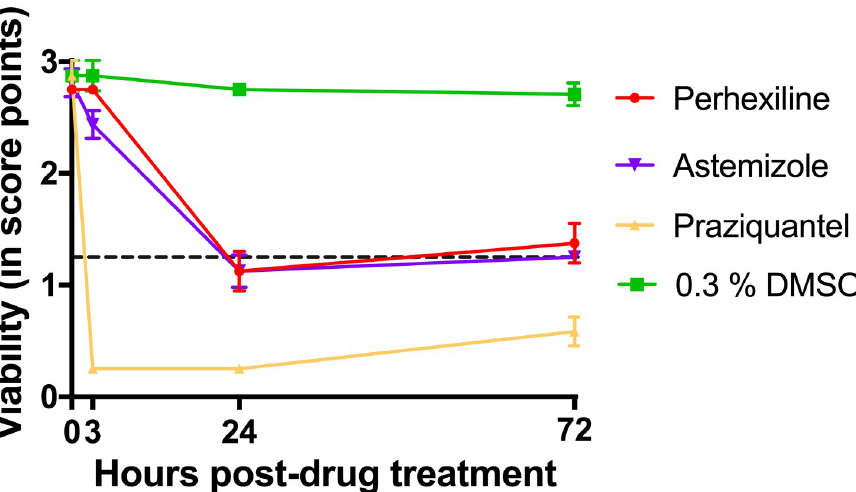
Fig 7. Confirmation of hits on adult S . mansoni worms. Hits were identified if an average viability score was � 1.25 (dashed line). Compounds, including praziquantel (PZQ, positive control) were tested at 30 μ M. DMSO (0.3% v/v) served as a negative control. Compounds and controls were removed and replaced with culture medium Hybridomed Diff 1000 supplemented with 200 U/mL penicillin, 200 μ g/mL streptomycin and 20% commercial human serum (S106B-EU) 24 h post-drug treatment (p.d.t). n = 2 per compound per timepoint; n = 4 at 0 h, 3 h, and 24 h p.d.t; n = 6 PZQ and 0.3% v/v DMSO. Data shows mean ± standard deviation. DMSO: Dimethyl sulfoxide; h: hours; v/v: volume by